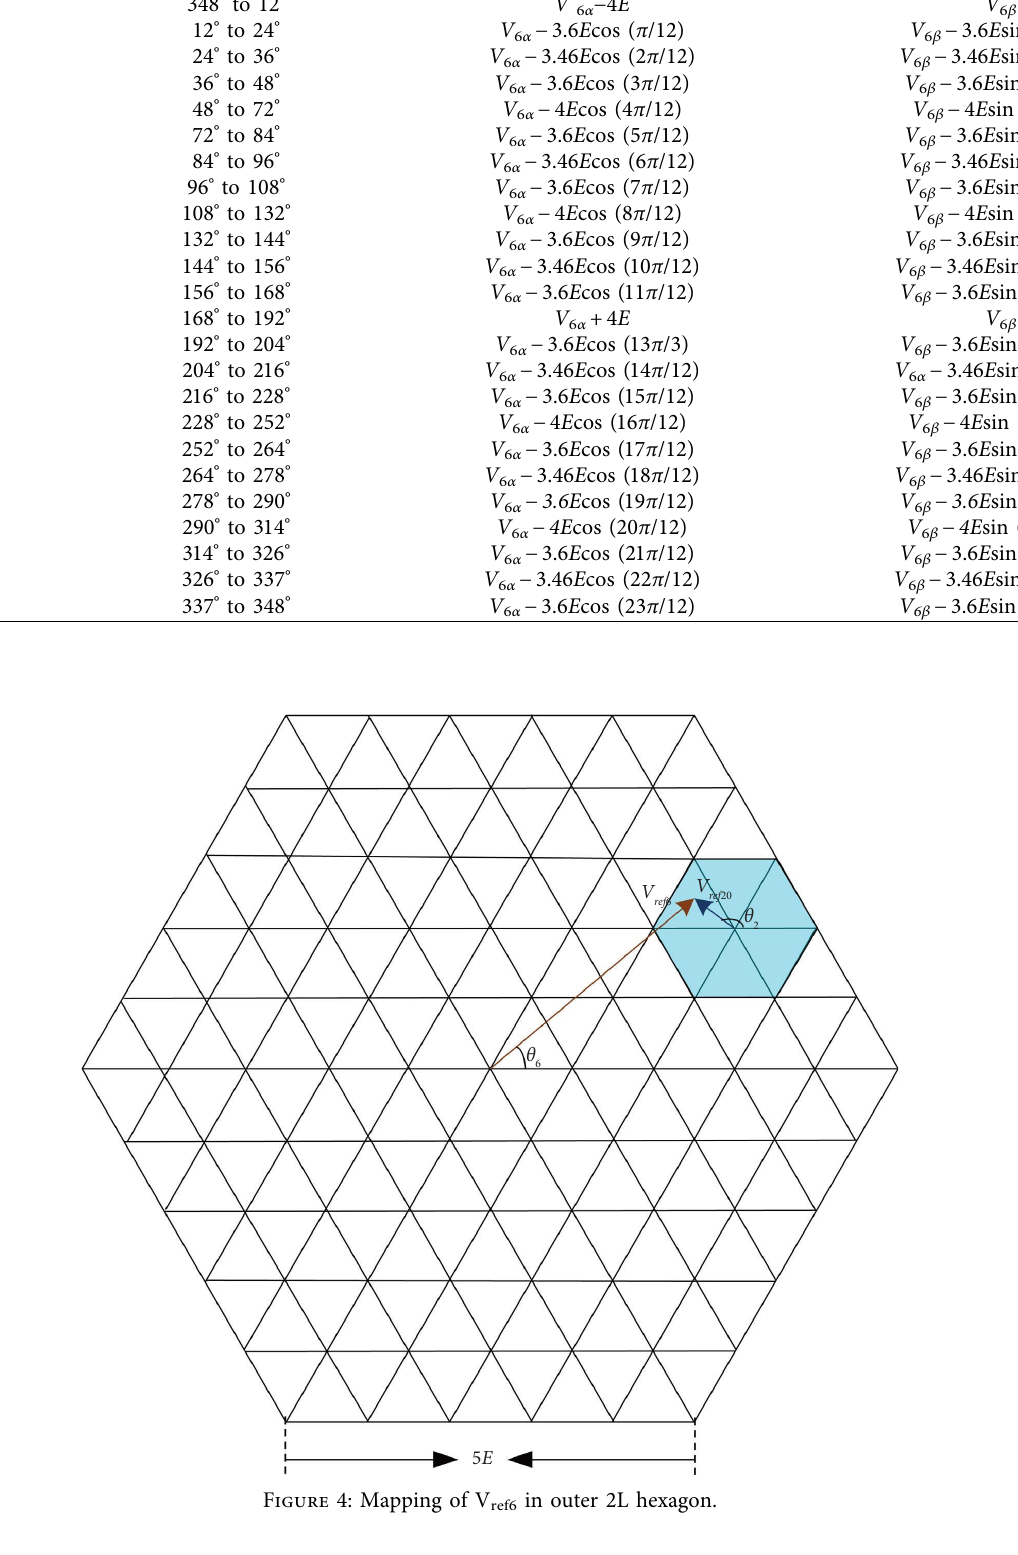
ref6 in outer 2L